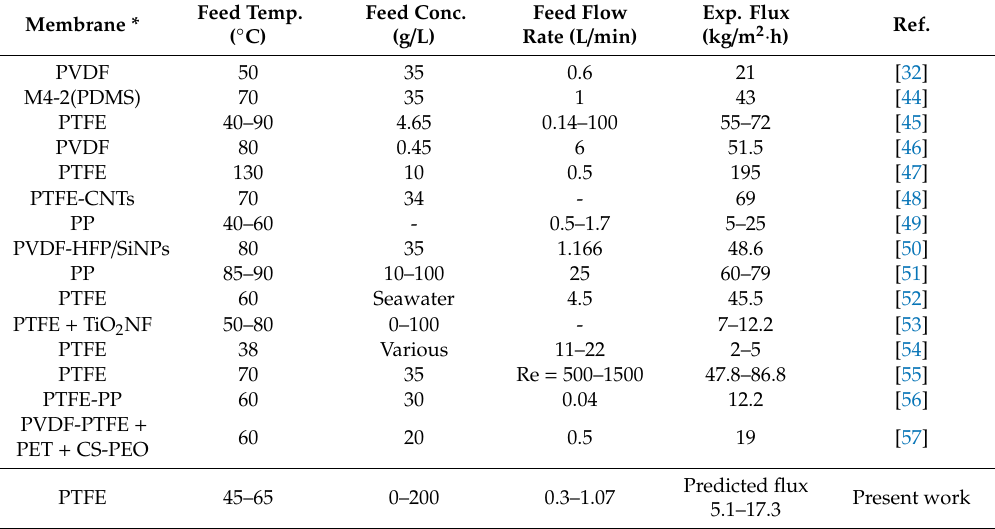
Table 1. Comparison between the performances of the predicted model in this study with various membranes found in the